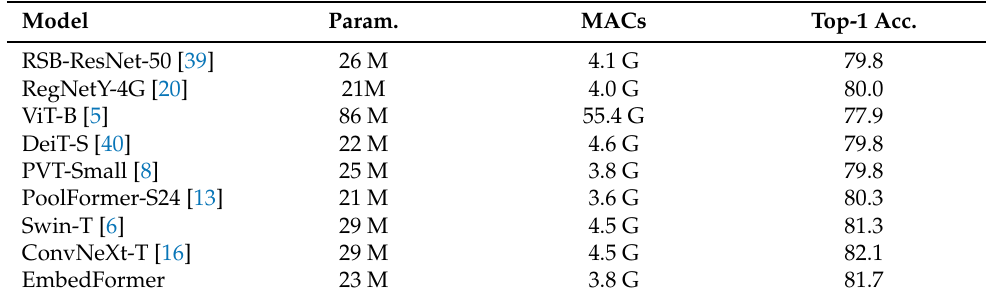
Table 1. The results of EmbedFormer and different mainstream backbones of similar complexity on ImageNet-1K. Model Param. MACs Top-1